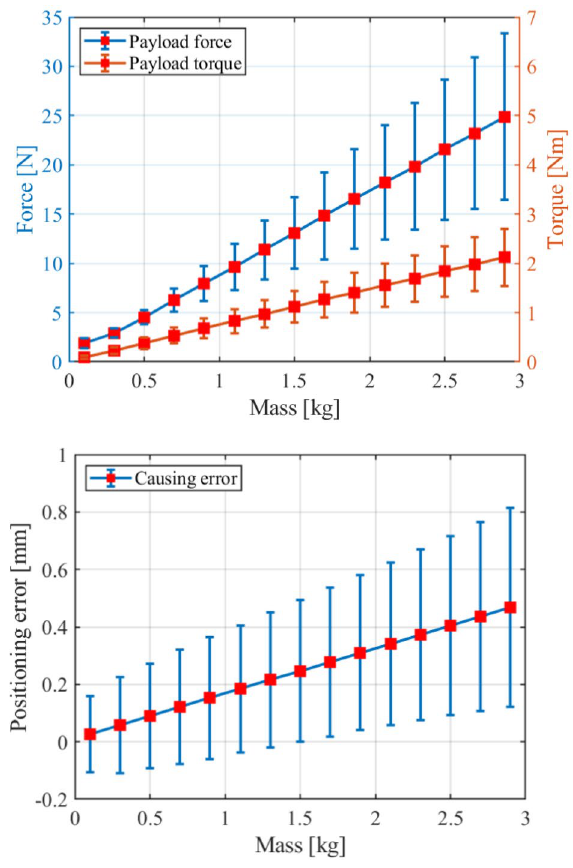
Figure 2. The illustration of cable effect and corresponding influence to robot with different cable